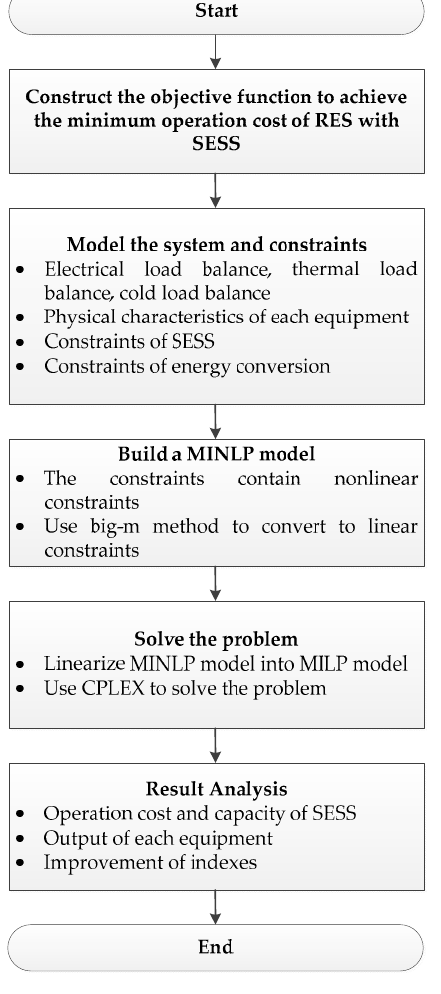
Figure 3. Model-solving